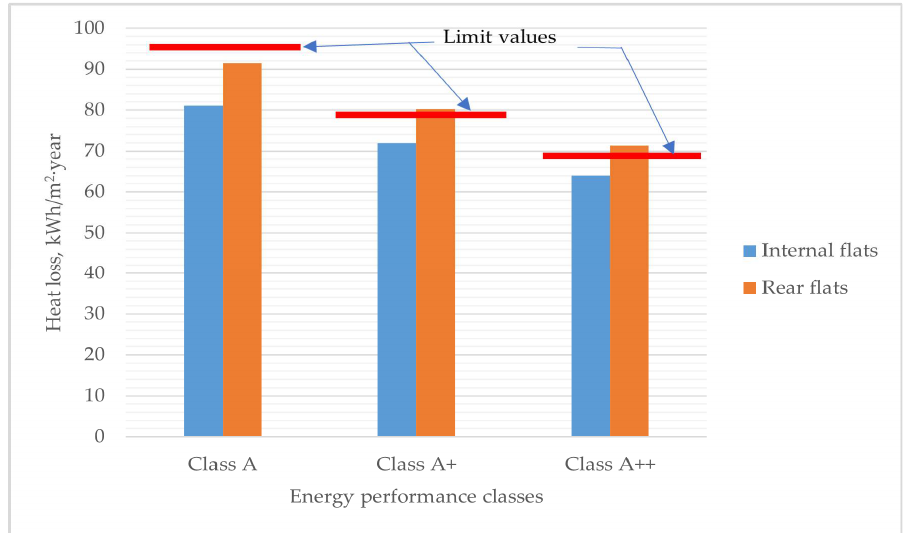
Figure 9. Comparison of heat energy loss values with limit values of different flat types.